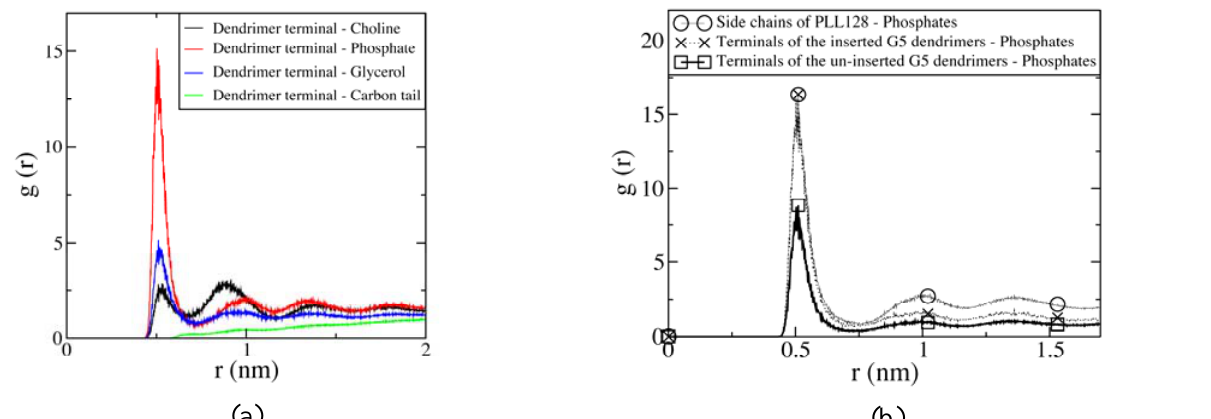
Figure 6 . RDFs for (a) DMPC head and tail groups with respect to terminals of the pore- inducing G5 dendrimer, and for (b) DMCP phosphate head groups with respect to side chains of PLL128 and terminals of the inserted and un-inserted G5 dendrimers. Reprinted with permission from [32]. Copyright 2008 American Chemical